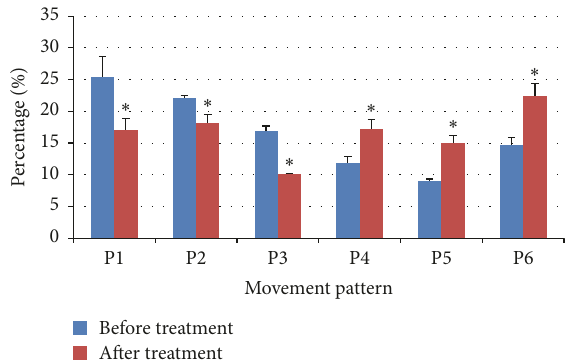
Figure 6: Percentage of movement patterns before and after treat- ments with toluene at 10mg/L. ∗ indicates significant difference, 𝑝 < 0.01 .